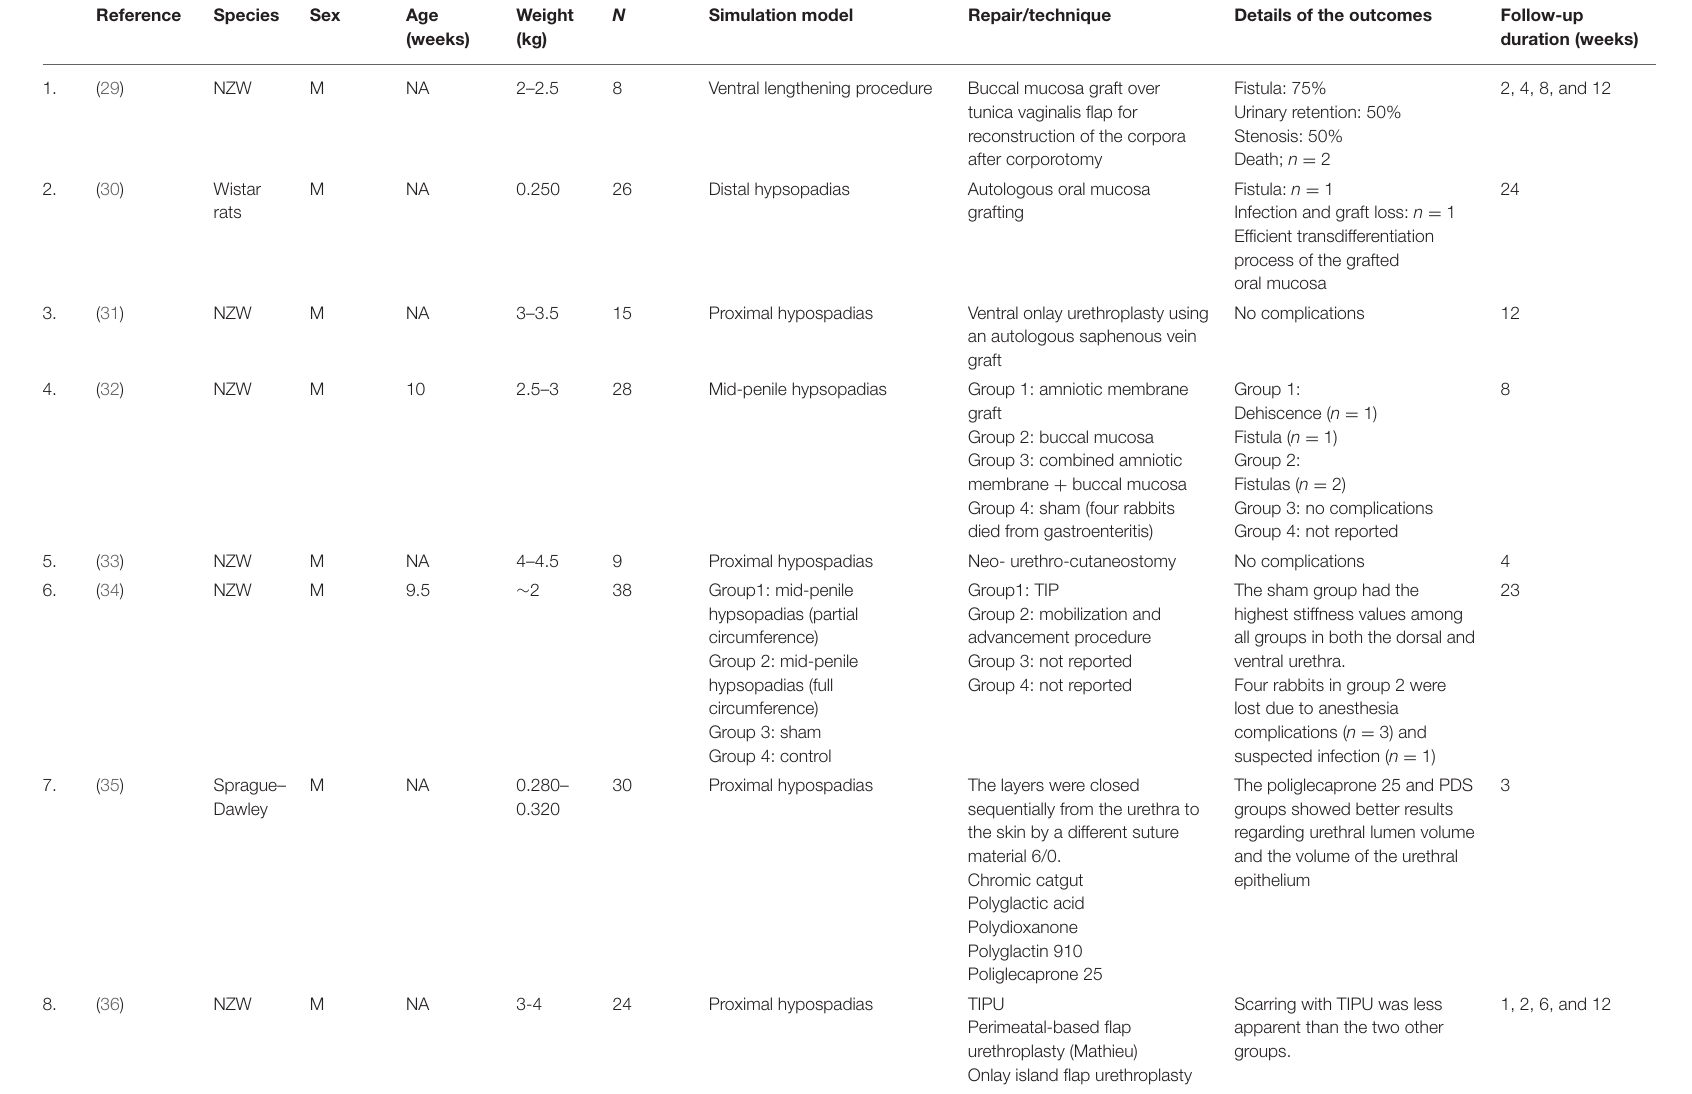
TABLE 1 | Overview of the studies included with a summary of the age, sex, and weight of the animal models utilized and evaluation of the hypospadias simulation model and